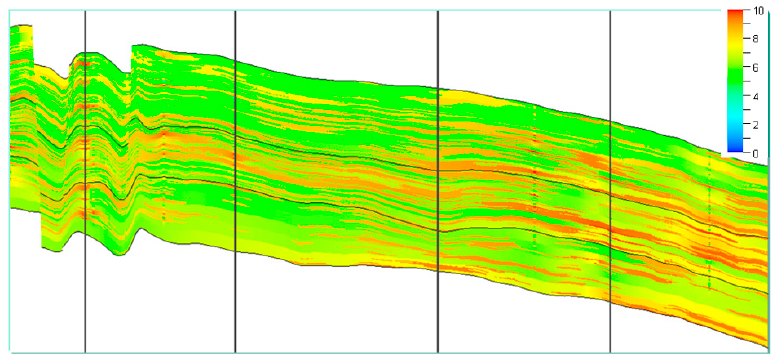
Figure 7. Cross-section map of horizontal principal stress difference in the N–S